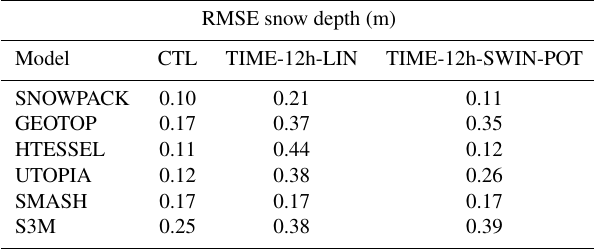
Table C1. Model RMSE for the simulated snow depth in the CTL run and the TIME-12h-LIN and TIME-12h-SWIN-POT experi- ments, compared to